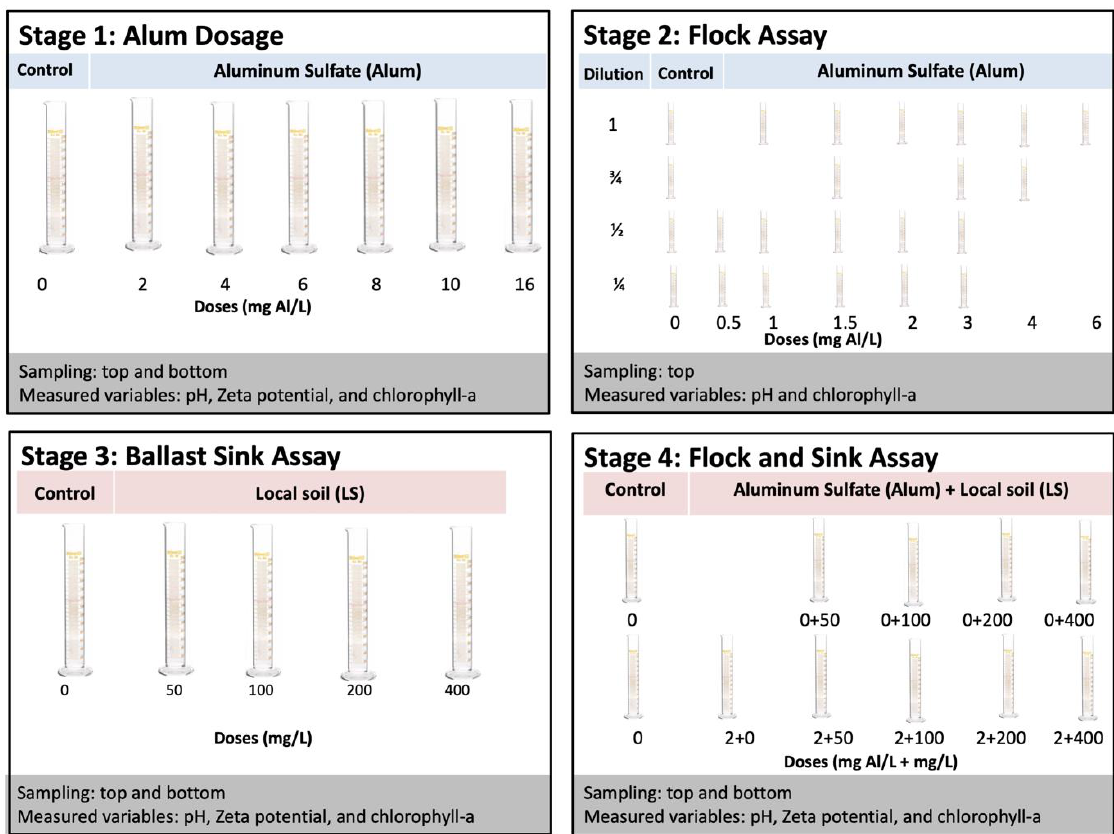
Figure 1. Diagram of experimental stages. In Stage 1, alum doses ranging from 0 to 16 mg Al/L were applied to eutrophic lake water; in Stage 2, the chlorophyll-a concentration was modulated by dilution and alum was dosed from 0 to 6 mg Al/L; in Stage 3, LS ballast was applied at doses from 0 to 400 mg/L; in Stage 4, the combination of low dose of alum (2 mg Al/L) and LS ballast was compared to ballast alone with doses of LS ballast from 0 to 400 mg/L.